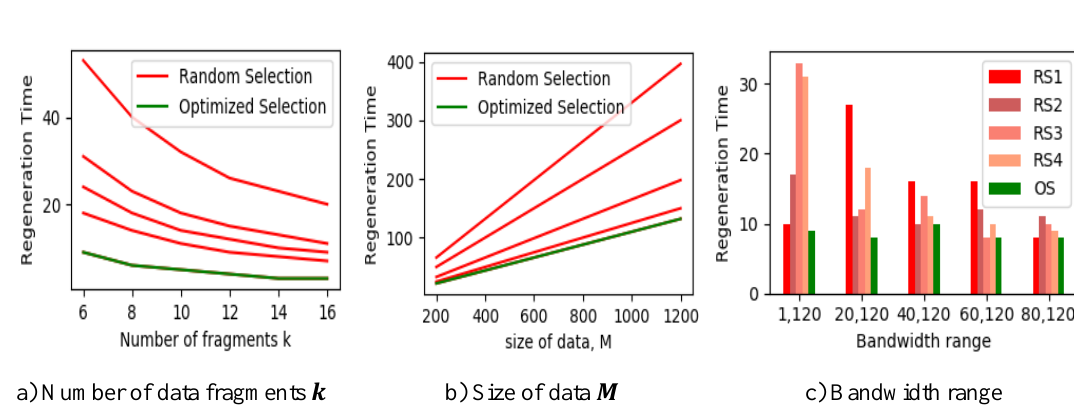
Figure 3. Graph for regeneration time for repairing data node failure for randomly selected newcomer node and optimized newcomer node selection.